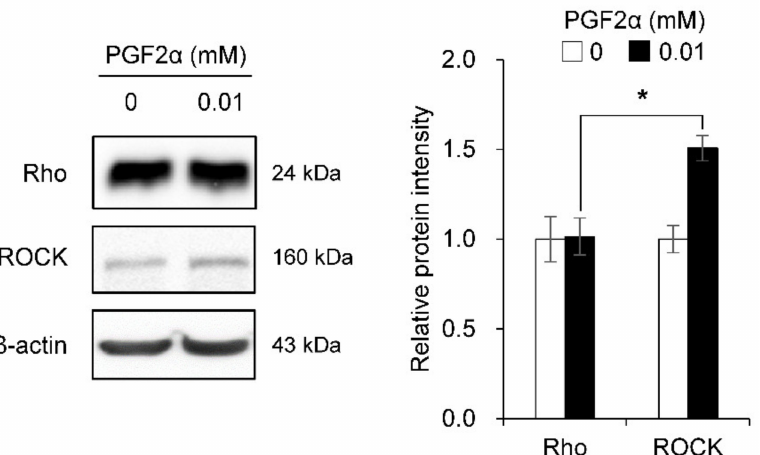
Figure 6. Influence of prostaglandin F2 alpha (PGF2 α ) on Rho and Rho-associated protein kinase (ROCK) protein in bovine luteal theca cells (LTCs). The protein was analyzed using western blotting. * p < 0.05, n = 5.